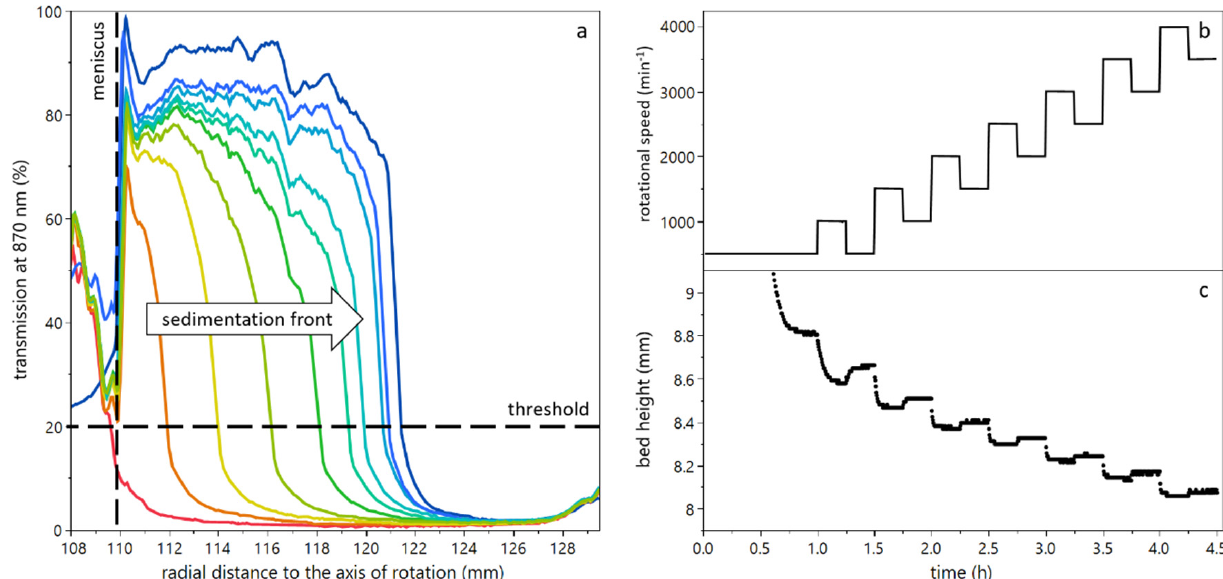
Figure 1. Working principle and set centrifugation steps during analytical centrifugation. The transmission of light as a function of radial position can be used to determine the sediment bed height ( a ). The rotational speed was increased stepwise with relaxation steps between ( b ) in order to determine compressibility as well as relaxation of the sediment in terms of the sediment bed height ( c ).